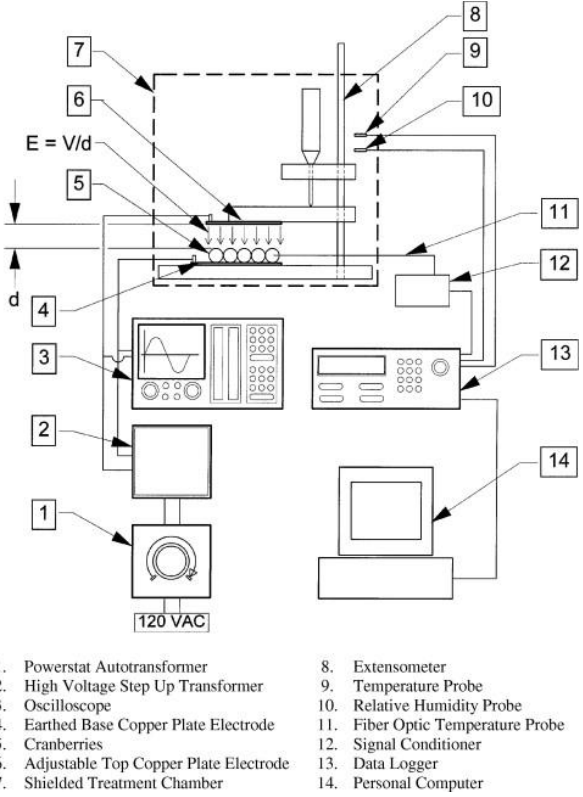
Figure 2. Schematic diagram of experimental set-up for high voltage field treatment of cranberry. Reprinted with permission from ref. [41]. Copyright 2008, Elsevier.